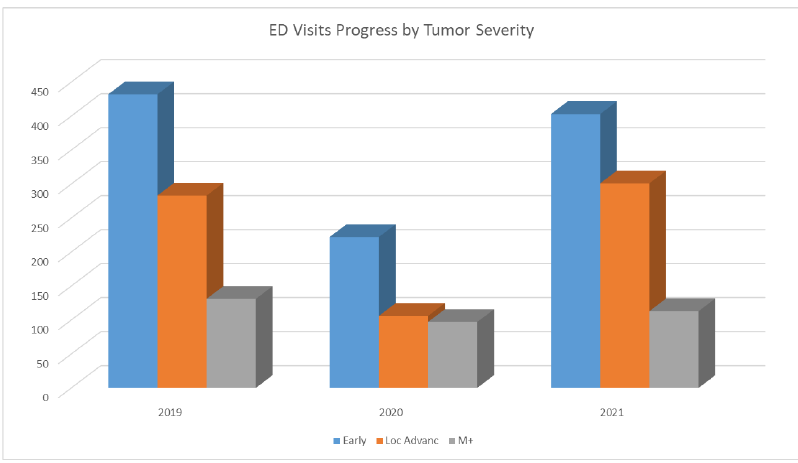
Figure 3. ED visits progress by tumor severity.